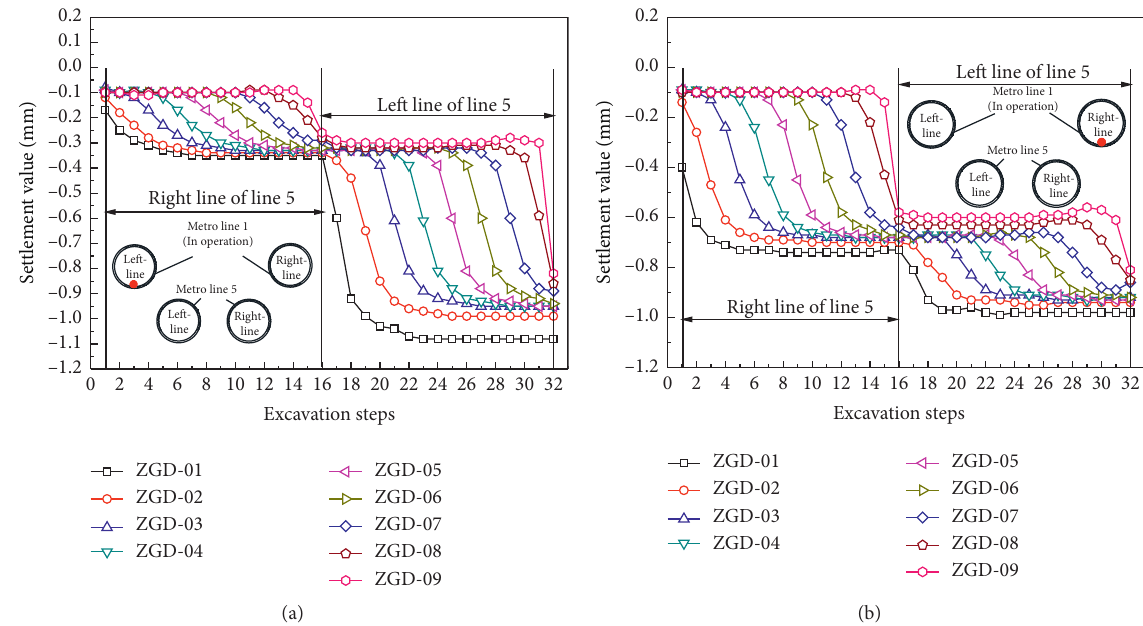
Figure 8: Arch bottom settlement of line 1 induced by the construction of line 5. (a) Bottom of left-line arch. (b) Bottom of right-line